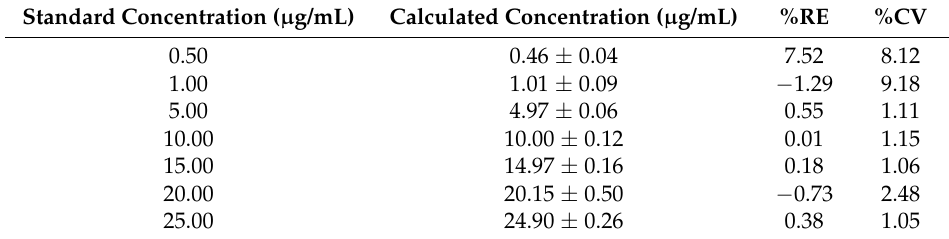
Table 2. Accuracy and precision inter-day data for HB standards solutions.